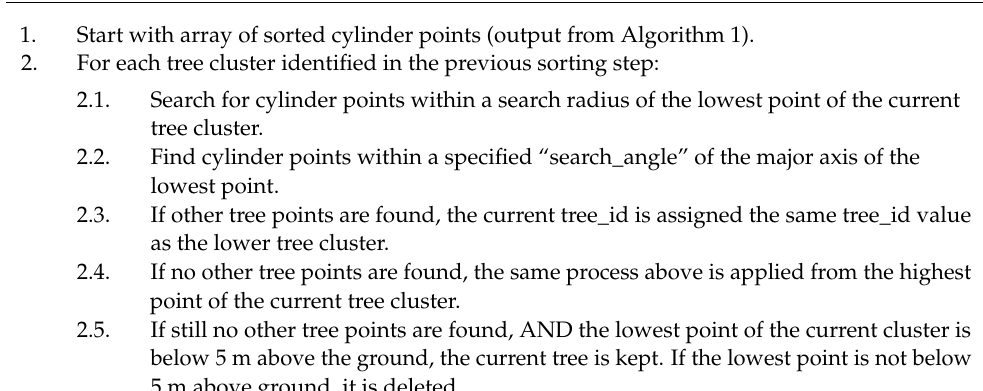
Algorithm 2. Cylinder Sorting Algorithm Part 2